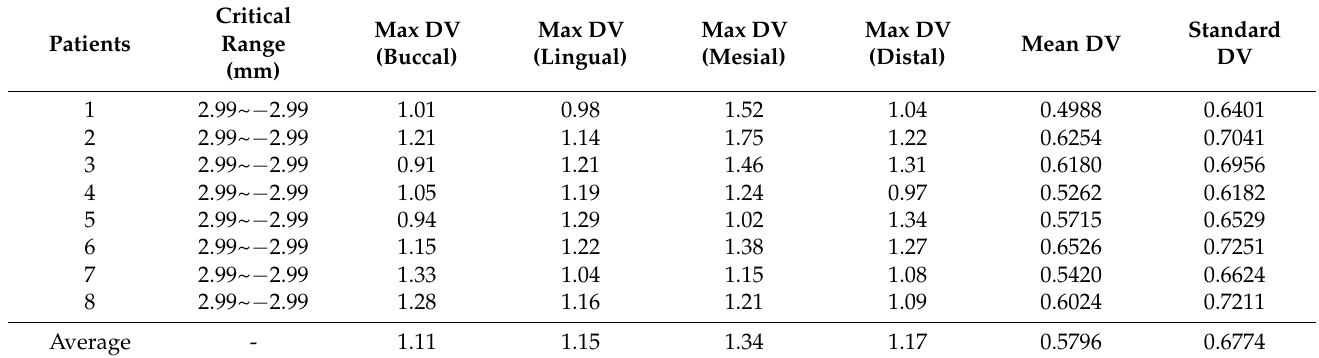
Table 3. Postoperative accuracy study of osteotomy in 3D deviation (mm) with T1 vs T0p.